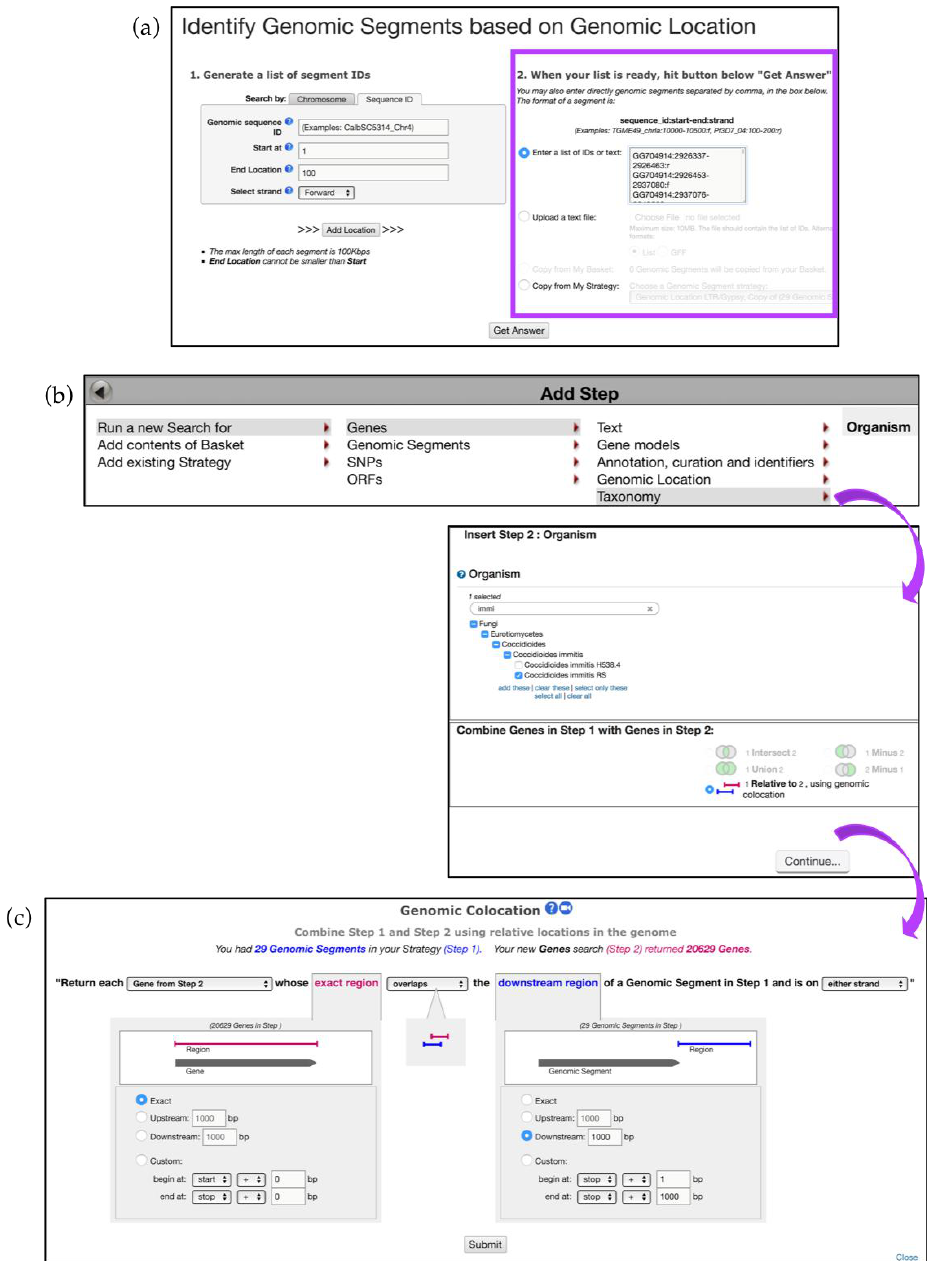
Figure 13. Using Genomic Location search to discover impact of Transposable Elements (TEs) on gene expression. ( a ) Identify TEs based on coordinates formatted to the accepted convention (e.g., sequence_id:start-end:strand). Paste a list of genomic coordinates in the highlighted section— Step 1 ( b ) Add Step and Run a new Search using a Taxonomy tool and identify C. immitis genes that are ( c ) 1000bp downstream of the previously identified TE elements—Step 2. Strategy in FungiDB: